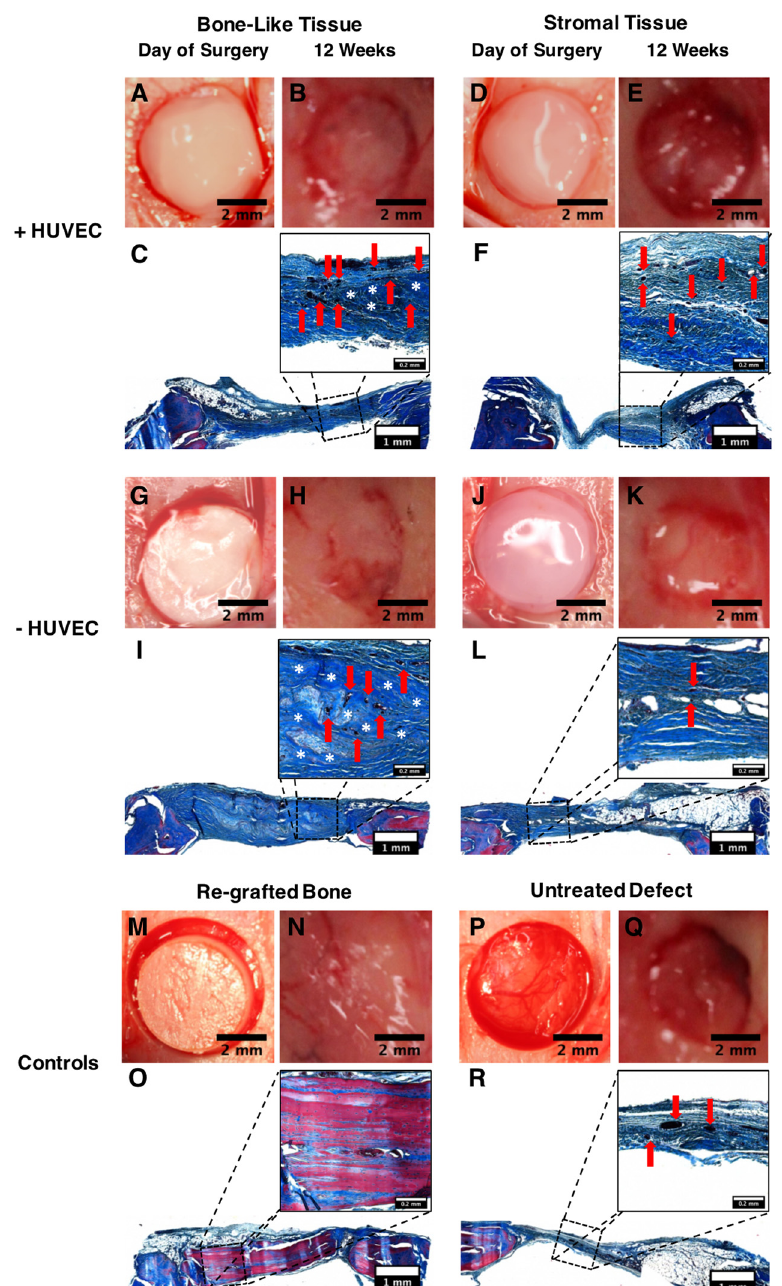
Figure 6. Rat calvarial bone defects grafted with the various types of tissues. Macroscopic images and histological cross-sections of the implantation sites on the day of surgery and 12 weeks after grafting ( A – R ). Bone defects filled with the reconstructed bone-like tissues and their associated histological features ( A – C ) and ( G – I ) compared to defect sites filled with the reconstructed stromal tissues ( D – F ) and ( J – L ). Re-grafted native rat calvarial bone ( M – O ) and untreated defect groups were used as references ( P – R ). Capillary blood vessels (red arrows), as well as new bone formation (white stars, intense blue) are visible at higher magnification (insets). Scale bars, ( A , B , D , E , G , H , J , K , M , N , P , Q ) 2 mm and ( C , F , I , L , O , R ) 1 mm and 0.2 mm (insets).